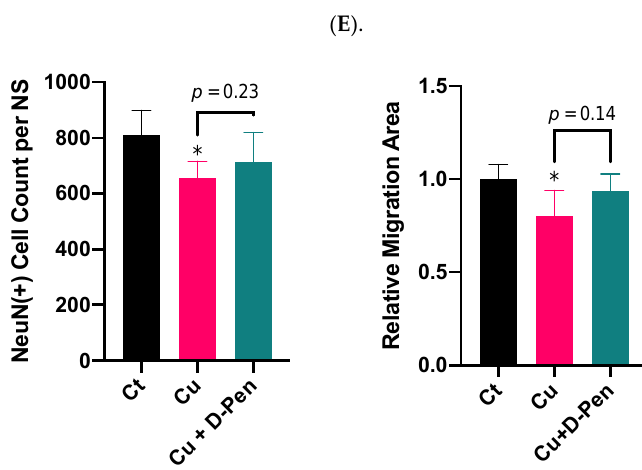
Figure 4. Chelating Cu by D-Pen restored Cu-suppressed neurosphere growth in vitro. ( A ). Phen Green imaging of differentiated neurospheres treated with 10- µ M Cu alone or 10- µ M Cu with D-Pen at 20 µ M. Control (Ct) neurospheres were cultured in Medium 3. Scale bar = 200 µ m. ( B ). Estimation of intracellular Cu burden by values of (F ct − F)/F ct , where F ct and F represents the average fluorescence intensity for controls and experimental neurospheres, respectively. Data represent mean ± SD, n = 4; ** p < 0.01 as compared with controls; # p < 0.05 as compared with Cu. ( C ). Neurosphere differentiation and migration as affected by Cu alone or by D-Pen chelation. Control (Ct) neurospheres were cultured in Medium 3. Neurospheres were stained with NeuN. Scale bar = 200 µ m. ( D ). NeuN(+) mature neurons per neurosphere were quantified in each group. Data represent mean ± SD, n = 6; * p < 0.05 as compared with controls. ( E ). Migration areas of neurospheres were quantified and normalized to the controls. Data represent mean ± SD, n = 6; * p < 0.05 as compared with controls.